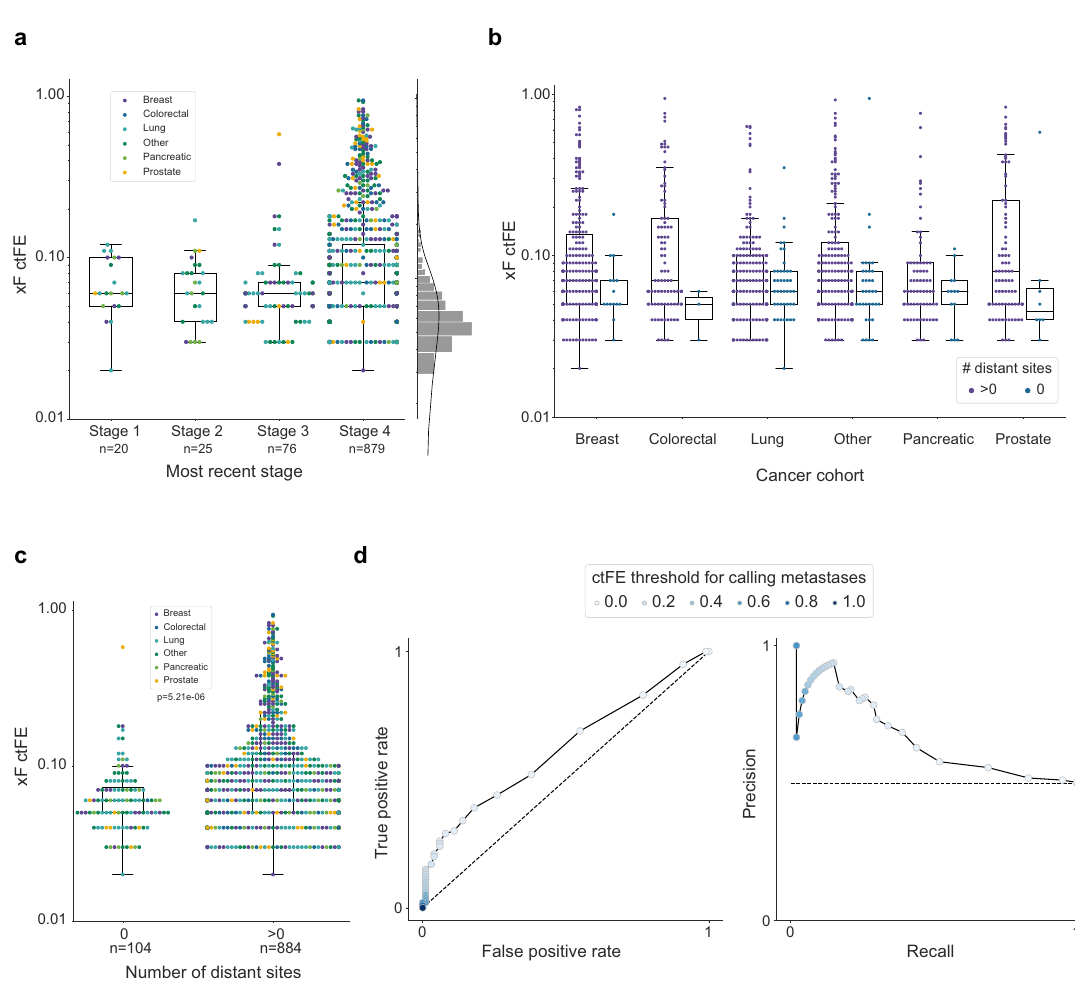
Fig. 4 Circulating tumor fraction estimate (cfTE) according to stage and number of distant metastases. a Among the xF 1000 cohort, there was a signi fi cant difference in ctFE between stages (Kruskal-Wallis P = 2.97e − 5). Overall, patients with stage 4 cancer ( n = 879, median ctFE = 0.07) had a higher ctFE than those with stages 1 ( n = 20, median ctFE = 0.06), 2 ( n = 25, median ctFE = 0.06), or 3 ( n = 76, median ctFE = 0.06). ctFE increased with the number of metastatic distant sites (Mann-Whitney U test P = 7.57e − 7) ( b ), and there was a signi fi cant difference in ctFEs between patients with no metastatic lesions ( n = 104) and those with 1 or more distant sites affected ( n = 884, Mann – Whitney U test P = 5.21e − 6) ( c ). d ROC and PR curves for calling metastases at different ctFE thresholds. Samples with and without identi fi ed metastases ( n = 100) were selected to calculate the curves with balanced classes. AUROC = 0.62 and AUPR = 0.64. The dashed lines show expectations when selecting samples at